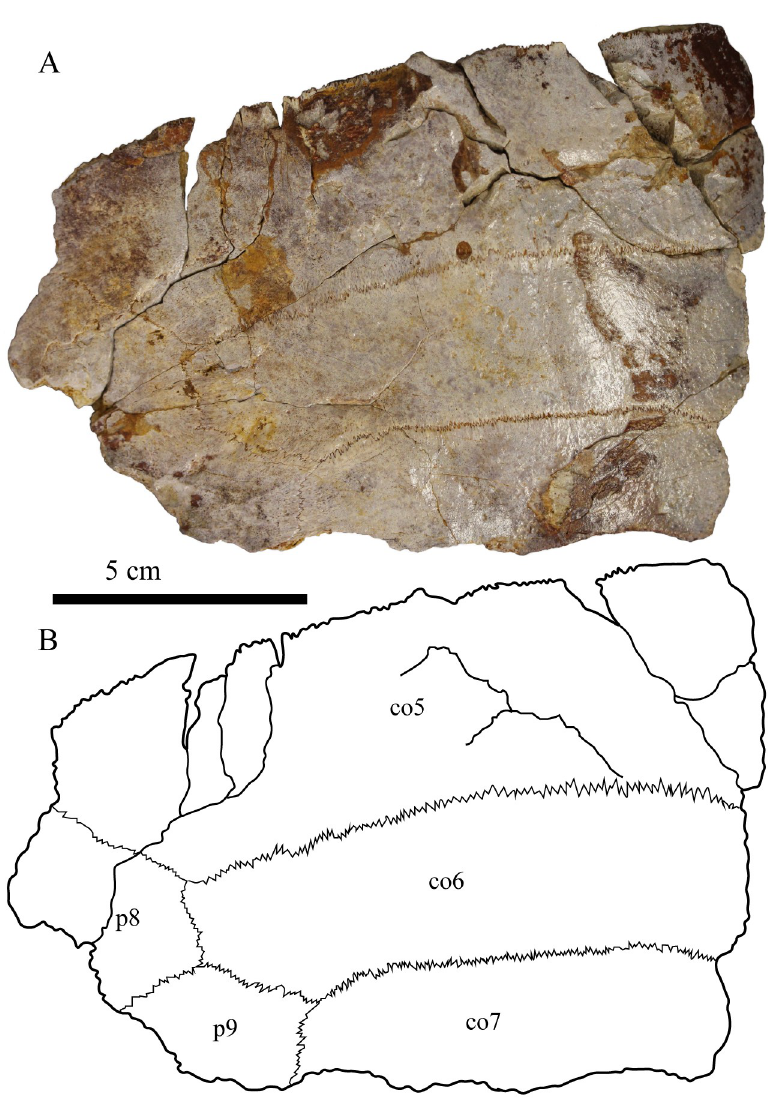
Fig 5. Carapace fragment MJSN CBE-0001 in dorsal view. Abbreviations: co, costals; p, peripherals.